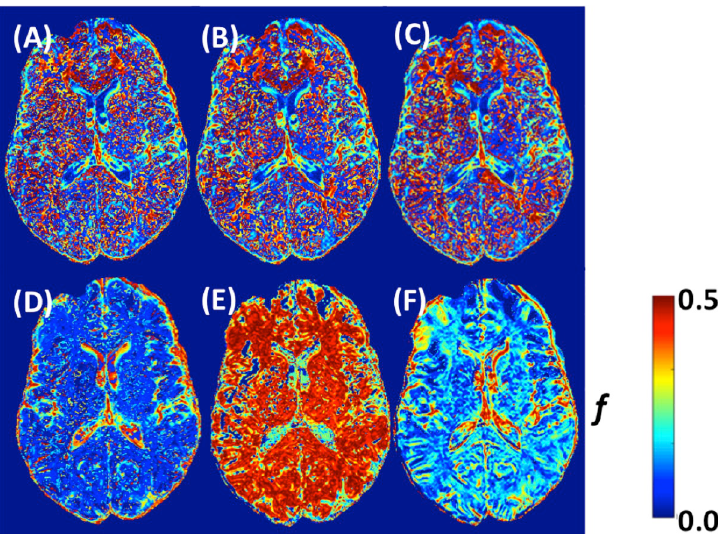
Fig 5. Example of IVIM f parameter maps with acquisition schemes found best according to their standard deviation for gray and white matter. b values (number of averages) (A) 3 min (0 (5), 200 (5), 900 (5) s/mm 2 ), (B) 6 min (0 (10), 200 (10), 900 (10) s/mm 2 ), (C) 12 min (0 (20), 200 (20), 900 (20) s/mm 2 ), (D) 12 min (0 (8), 10 (8), 20 (8), 40 (8), 80 (8), 140 (8), 200 (8), 900 (8) s/mm 2 ), (E) 6 min (0 (5), 20 (9), 40 (1), 80 (1), 110 (9), 140 (1), 170 (2), 500 (3), 600 (1) s/mm 2 ), (F) 12 min (0 (7), 20 (4), 140 (19), 300 (9), 500 (19), 700 (1), 800 (4), 900 (1) s/mm 2 ).